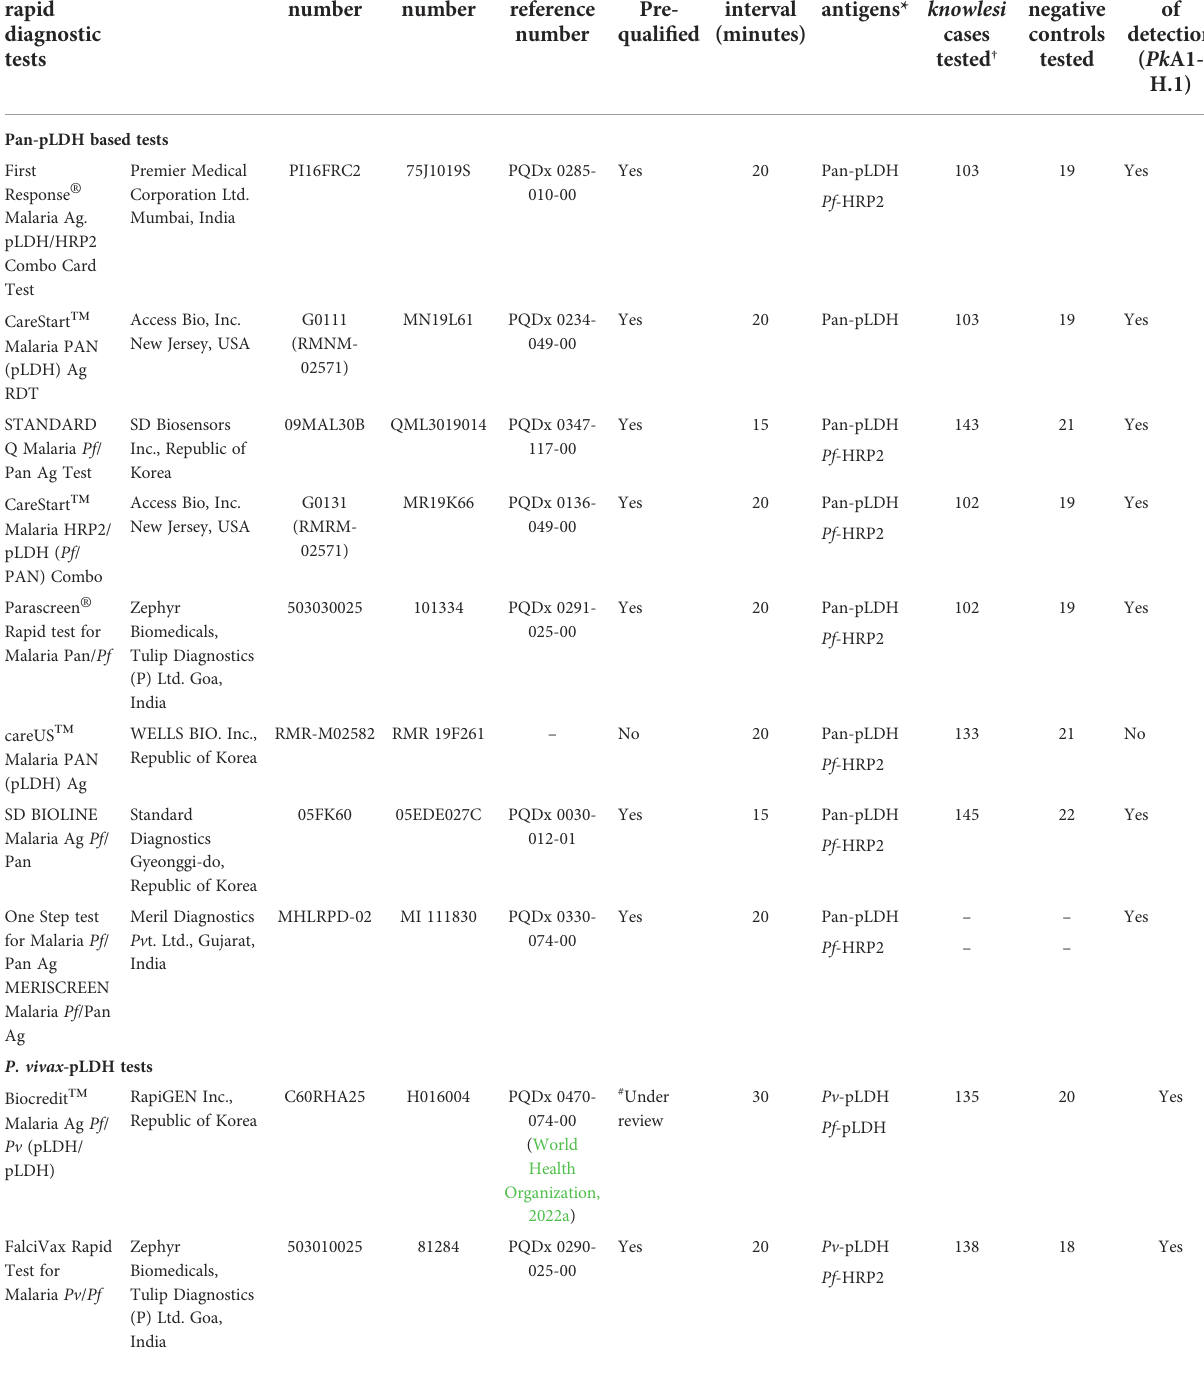
TABLE 1 Product information, target antigens and clinical data for the ten rapid diagnostic tests evaluated for P. knowlesi detection. Malaria